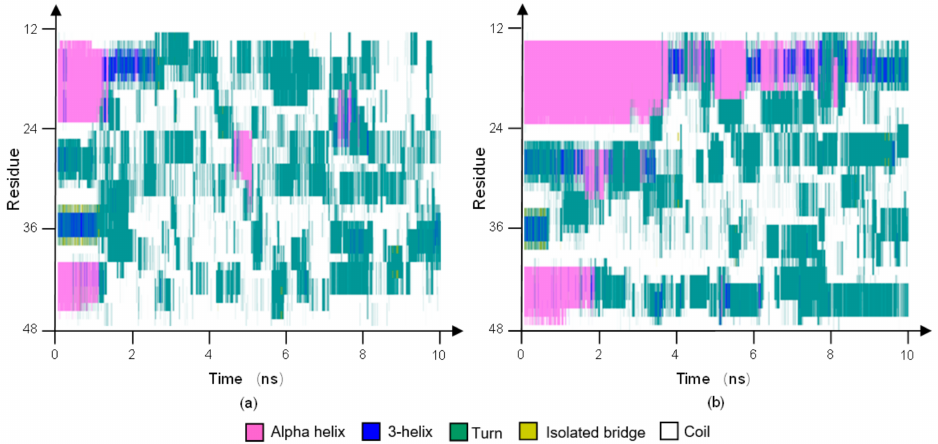
Figure 6. (Color online) Stride evolution of secondary structures of the protein 1BBL exposed in the ( a ) pulsed and ( b ) oscillating electric fields with a frequency of 1000 MHz,